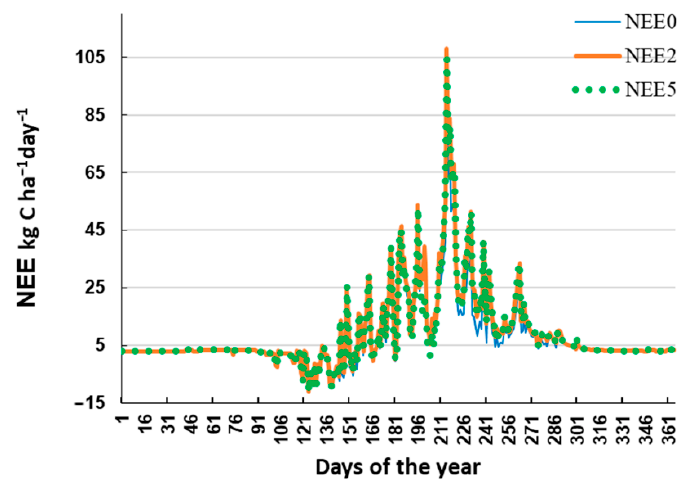
Figure 11. Modelled daily variations of the Wetland-DNDC model NEE sensitivity analysis to the “Field capacity“ input parameter for Great Vasyugan Mire in 2019.